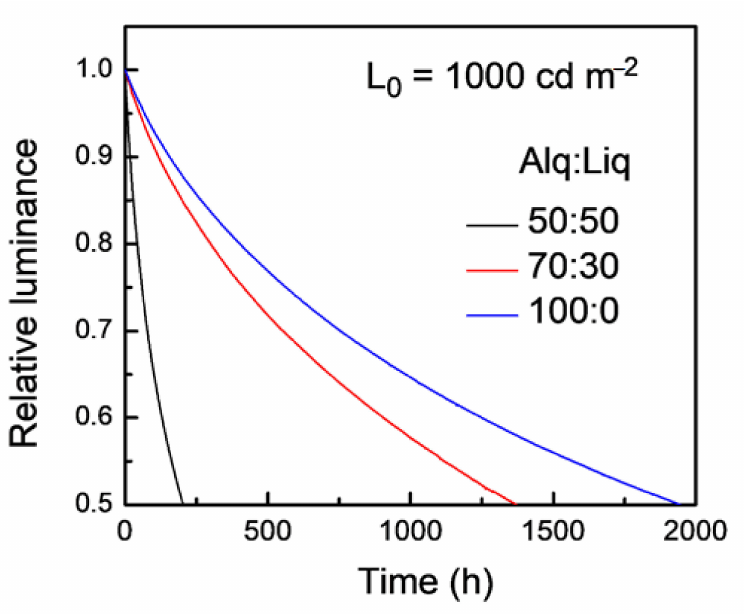
Figure 5. LT of the devices with different weight ratio of Alq 3 :Liq in ETL. The initial luminance is 1000 cd m − 2 for all